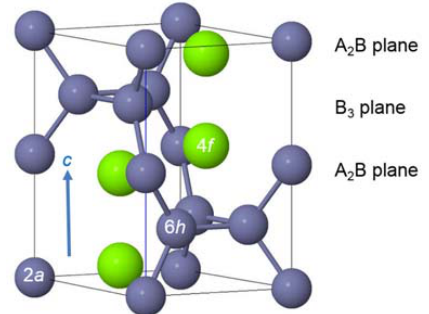
Figure 6. Schematic of the C14 structure. Green and blue spheres represent the A ‐ (Zr, Ti, and Pd) and B ‐ (V, Cr, Mn, Co, Ni, and Al) atoms, respectively. While two sites (2 a on the A 2 B plane and 6 h on the B 3 plane) are available for the B ‐ atoms, only one site (4 f ) on the A 2 B plane is available for the A ‐ atoms.